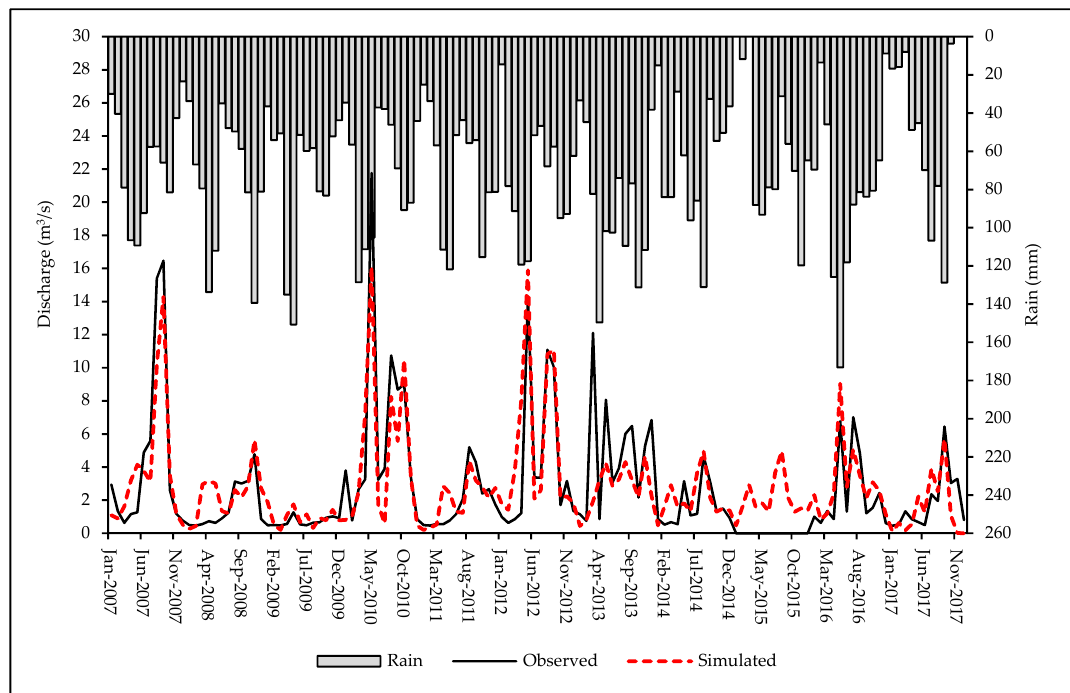
Figure 6. Simulated and observed monthly discharge for calibration (2007–2012) and validation (2013–2017) periods against rainfall. No observed discharge data were available for the 2015 period.